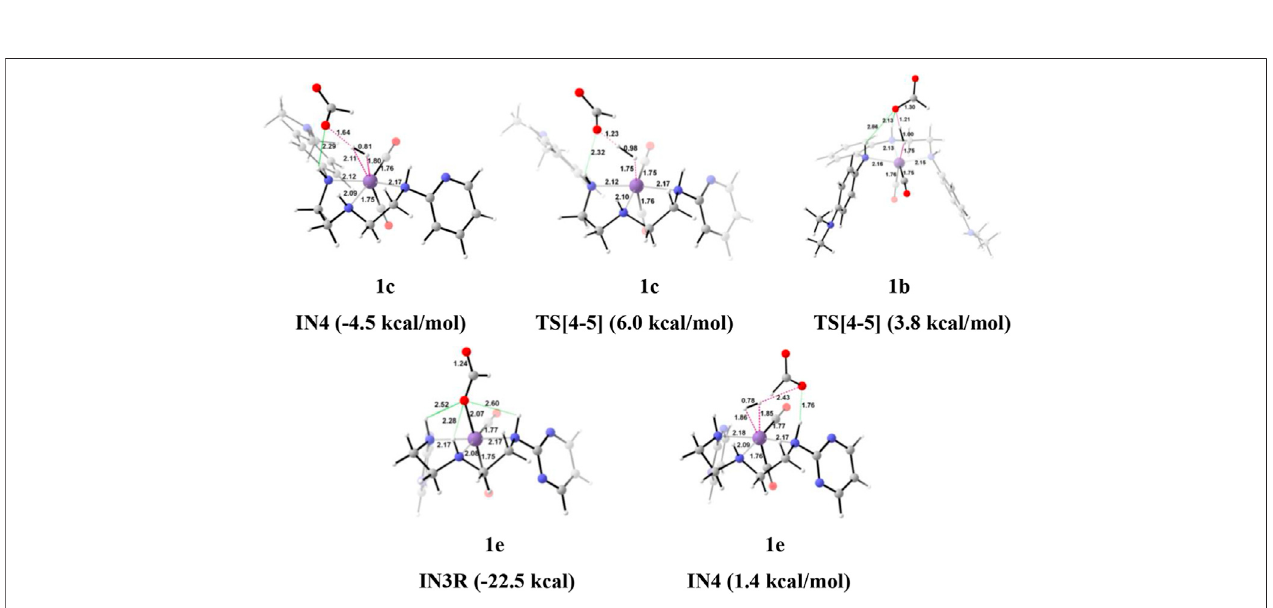
FIGURE5| Theoptimizedgeometriesoftheintermediatesintheformationofformicacidfromcarbondioxide.ThebondlengthsareinÅ,andtherelativeGibbsfree energies are in parentheses (Figures are shown in Supplementary Data Sheet S1 for all the optimized geometries of all the transition states and intermediates).